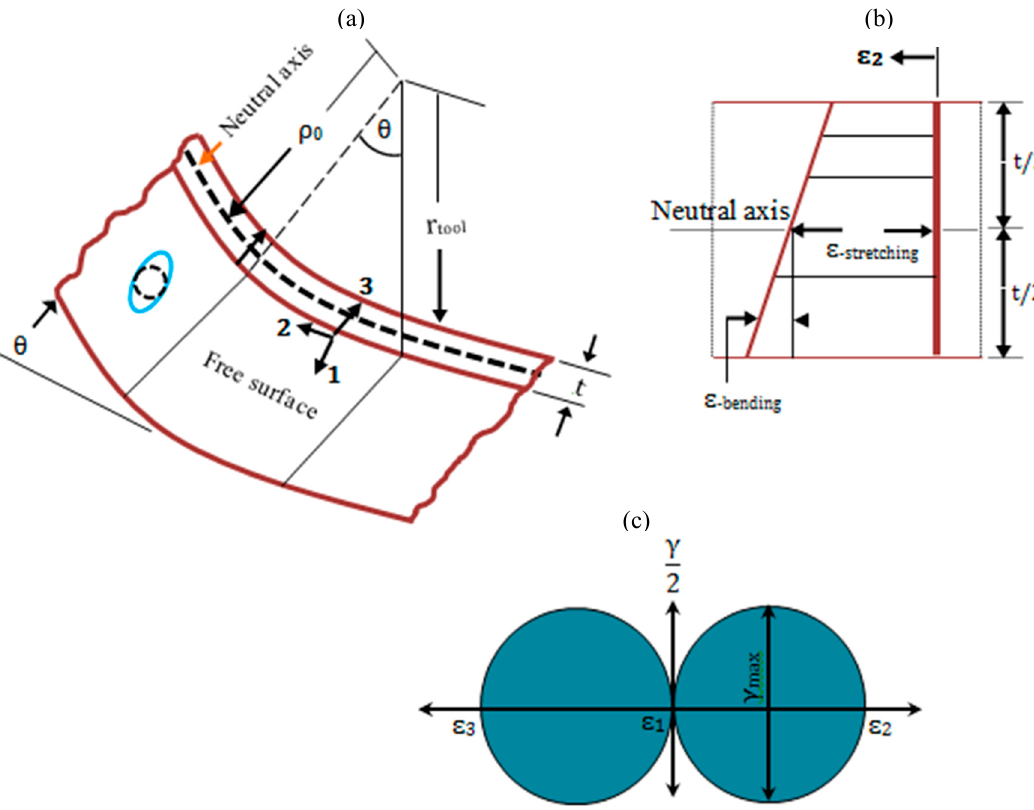
Figure 3. Schematic of a flat section of the pyramid deformed under combined bending and stretching loads in ISF: ( a ) Deformed section, ( b ) through-thickness distribution of normal strain, and ( c ) the state of strain on the flat section of pyramid.